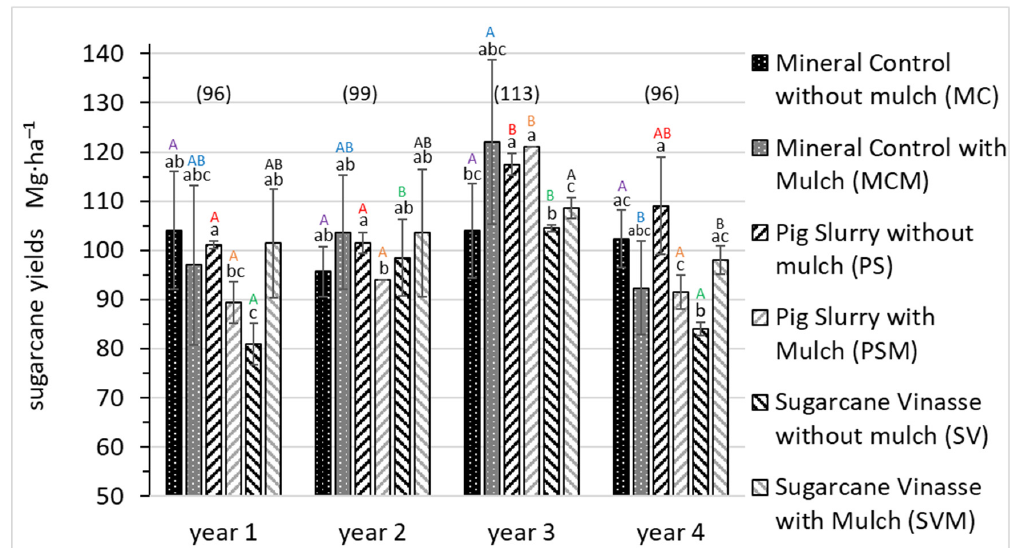
Figure 1. Sugarcane yields obtained with each treatment in the four experimental years. The average yields produced by all the treatments in each year are shown in brackets. Error bars correspond to standard deviations between replications for each treatment ( n = 6). Identical letters indicate no significant differences between two treatments. Small letters compare treatments in a given year and capital letters compare treatments between the years.